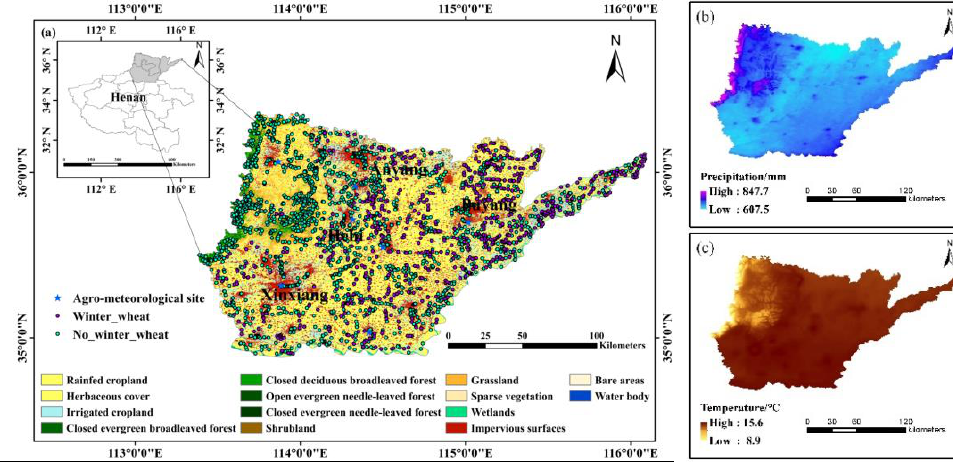
Figure 1. Geographical location of the study area: ( a ) Distribution of sample points. The main map is based on the 30-m global land cover product fine classification system for 2020, ( b ) Annual cumulative precipitation data in 2020, ( c ) Monthly average temperature data in 2020.